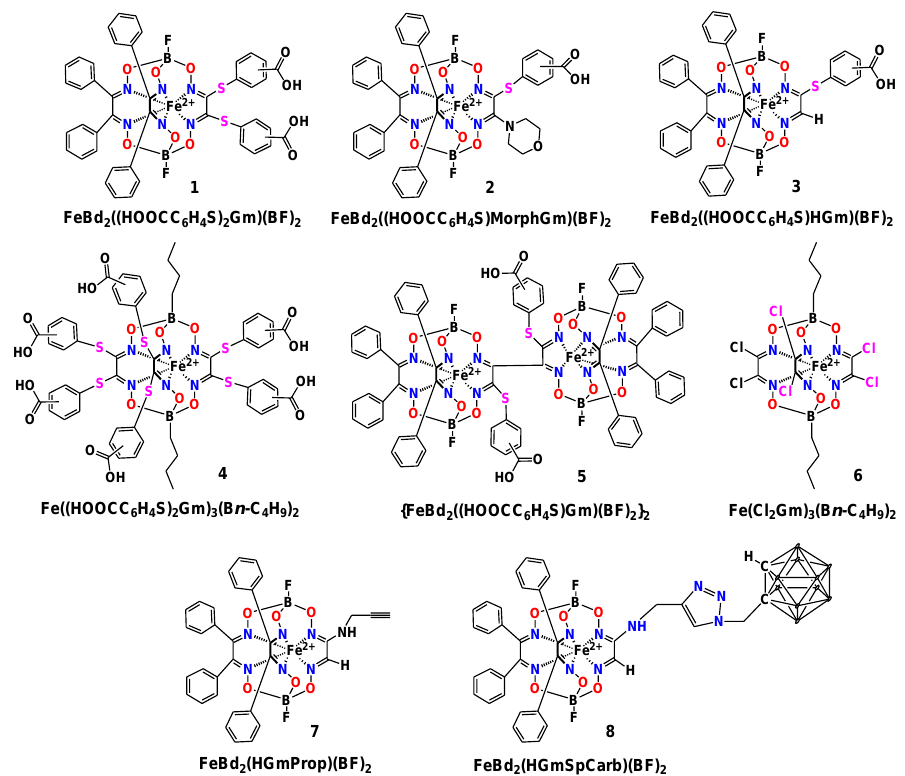
Scheme 1. Chemical drawings of the iron(II) cage complexes under discussion.